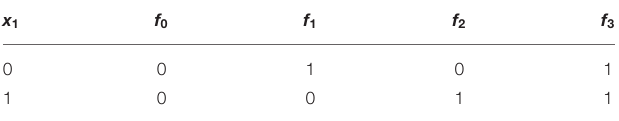
TABLE 1 | Every possible unary Boolean function.